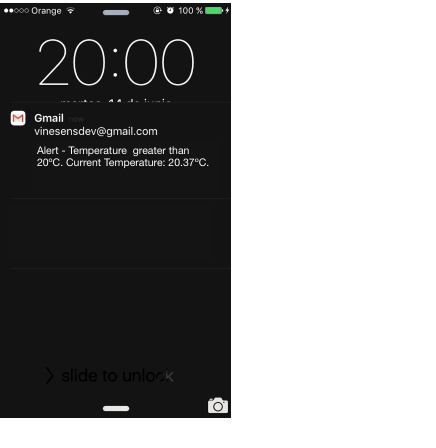
Figure 15. Alerts received through e-mail ( left ) and SMS ( right ).